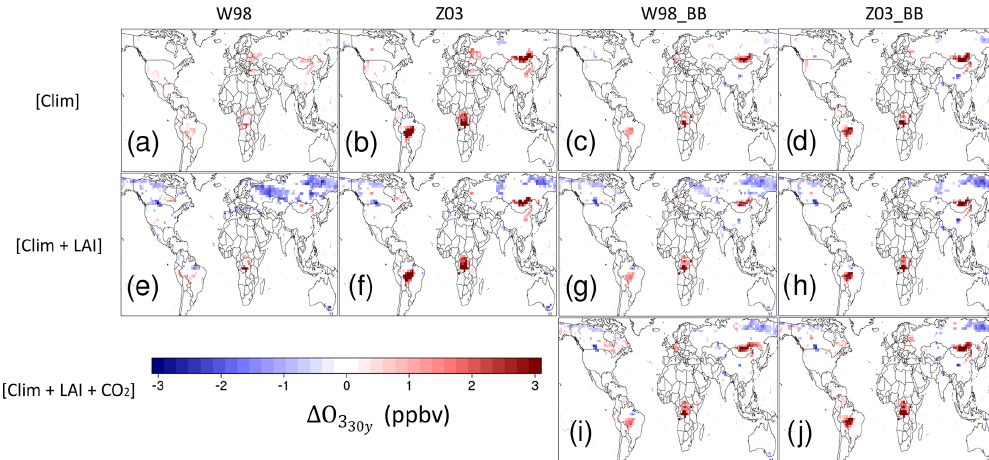
Figure 9. Estimated impact of trends of July mean daytime v d on July mean surface ozone ( (cid:49) O 330 y ) during 1982–2011 over vegetated land surface. Only grid points with statistically significant trends ( p < 0 . 05) in July mean daytime v d are